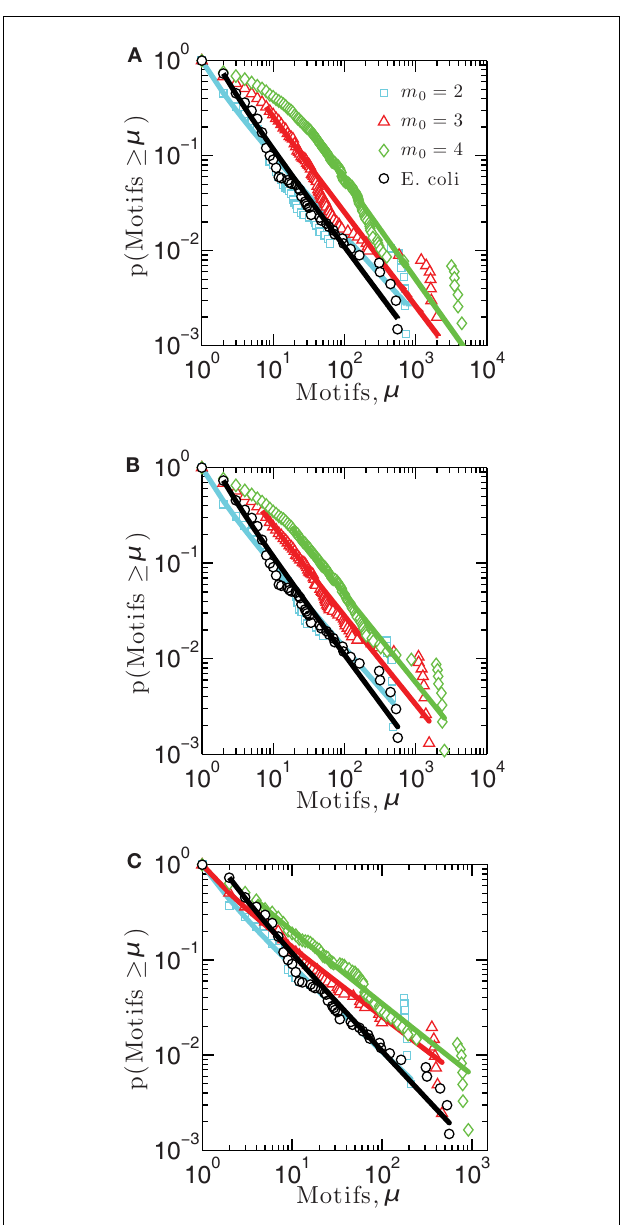
FIGURE 3 | Cumulative distribution functions measuring the probability that a measurement made on a network node gives a number of motifs greater than µ , for each of three model networks built using (A) linear attachment kernels, (B) power-law kernels, and (C) sigmoidal